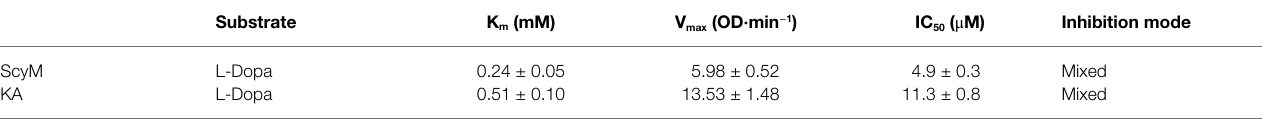
TABLE 2 | Kinetic and inhibition constants of tyrosinase by ScyM and